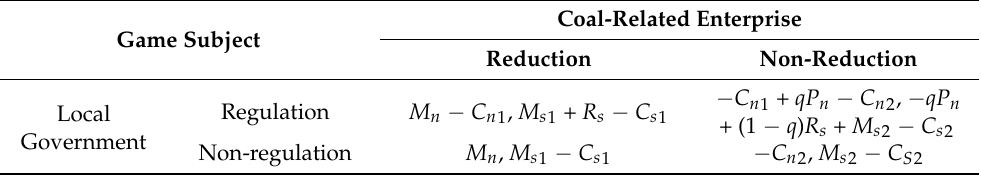
Table 1. The payoff matrix for local government and coal-related